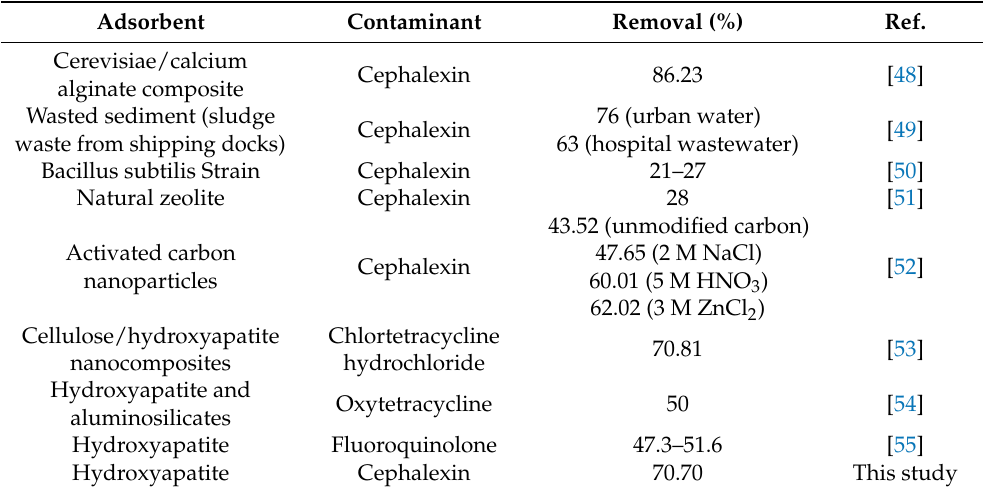
Table 1. Removal efficiency comparison of Ceph on HAP with other related